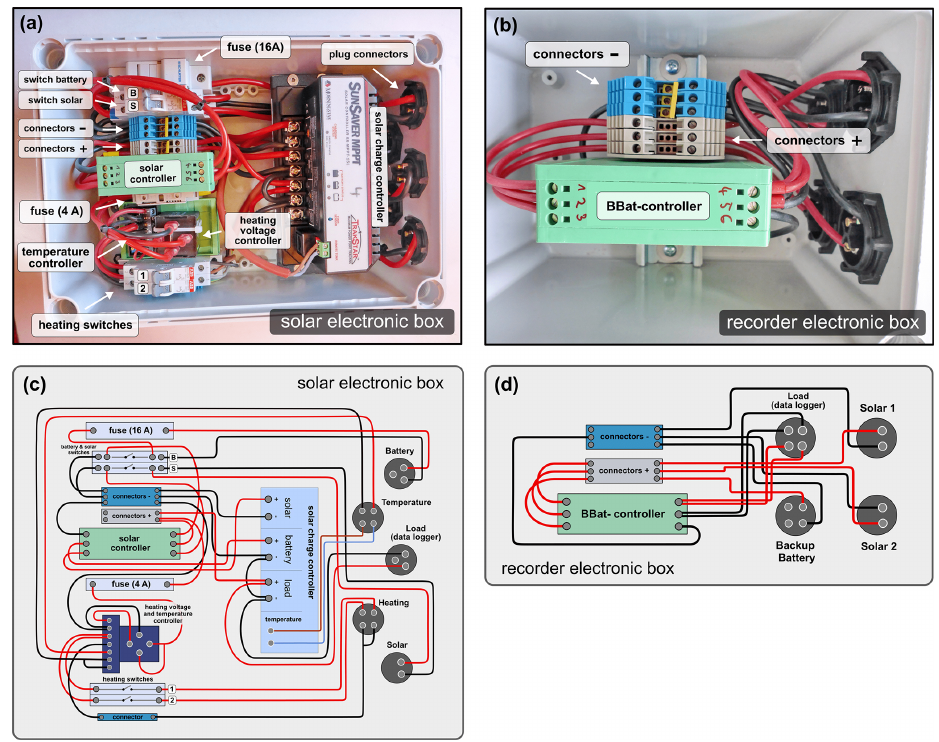
Figure 4. Electronic boxes indicated in Figs. 2 and 3d, e. Panel (a) shows the solar electronic box containing the solar charge controller, the solar controller and additional electronics. Panel (b) shows the recorder electronic box and contains the backup battery management controller (BBat controller). The schematic wiring of the components for the solar and recorder electronic boxes is shown in (c) and (d) ,